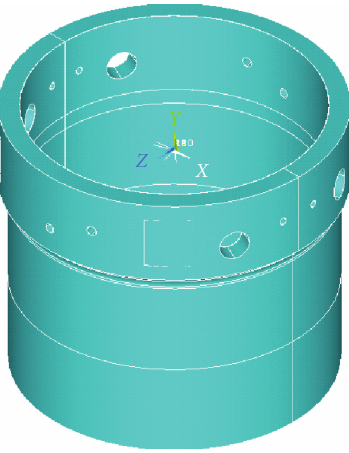
Figure 8: Structural mechanics model overall